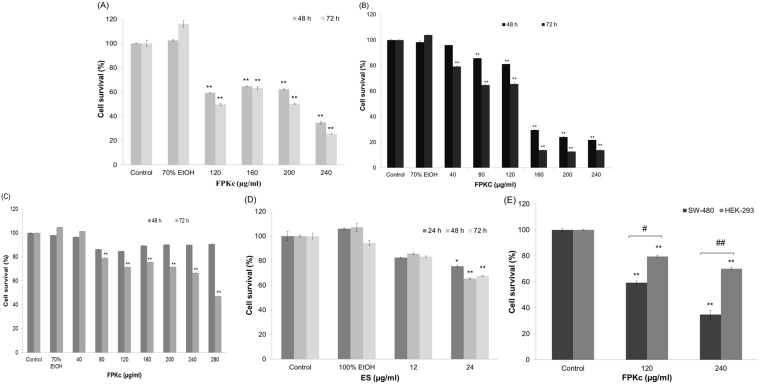
Cell cytotoxicity.SW-480, SW-620, Caco-2 and HEK-293 cells viability after FPKc (A, B, C, D) and ES (E) treatment was measured by MTT assay. Each value was expressed as a mean ± S. D. of at least three independent determinations. One-way ANOVA was used for comparisons of multiple group means followed by Dunnett’s t-test. *P<0.05 and **P<0.01 versus the control. (error bars = S. D., n = 3).